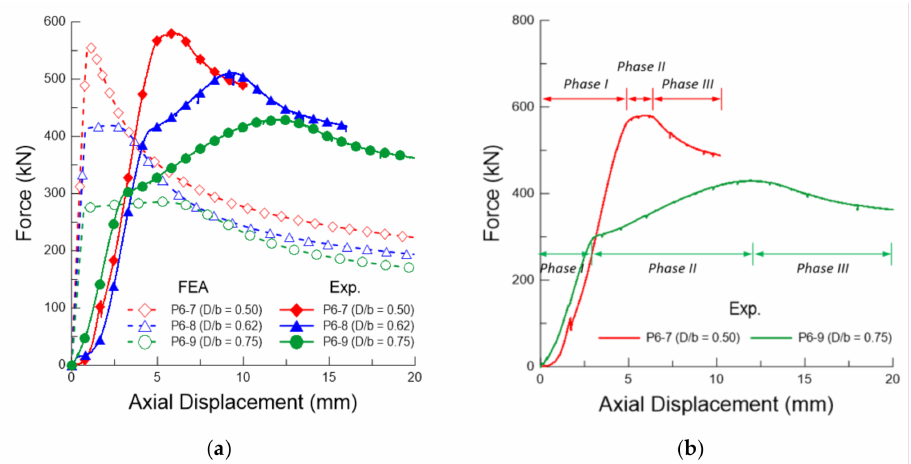
Figure 6. ( a ) Force–axial displacement curve and ( b ) the three phases behavior of the perforated